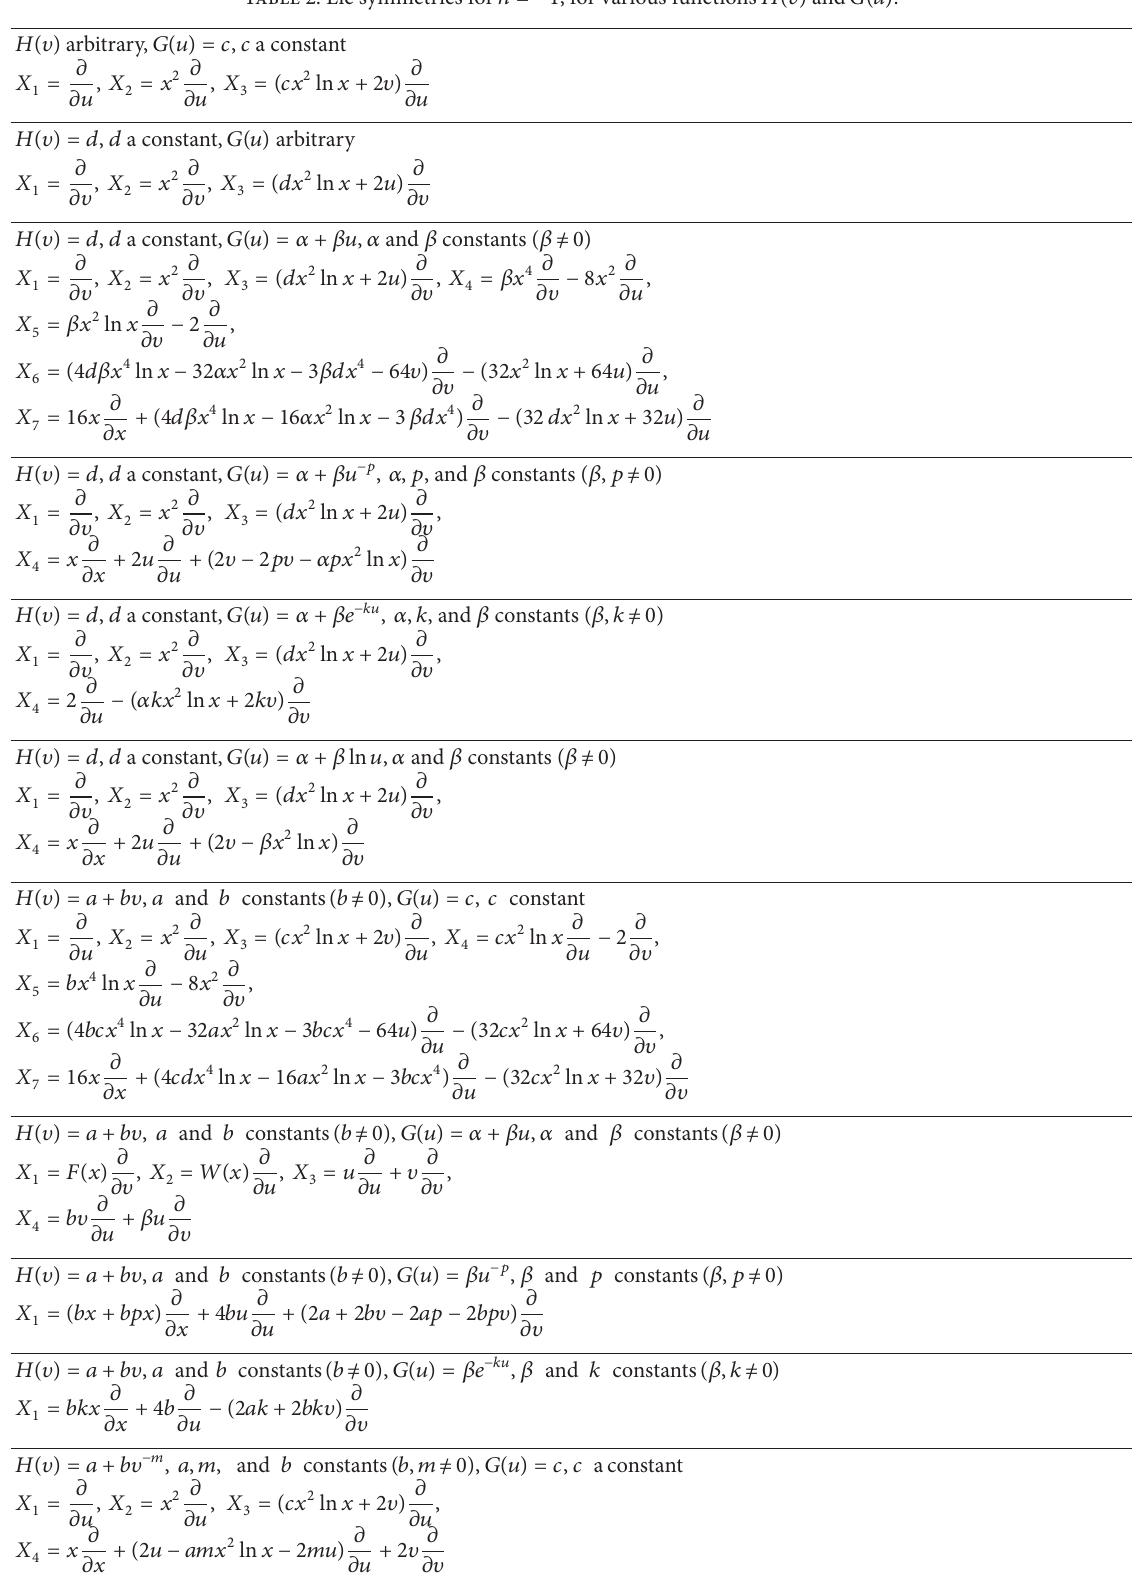
Table 2: Lie symmetries for 𝑛 = −1 , for various functions 𝐻(𝑣) and 𝐺(𝑢) . 𝐻(𝑣) arbitrary, 𝐺(𝑢) = 𝑐 , 𝑐 a